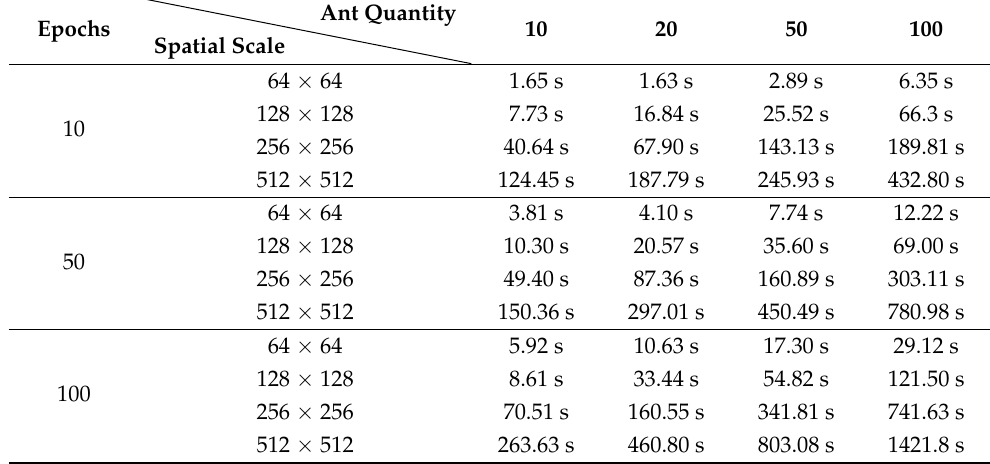
Table 1. The classical ant colony